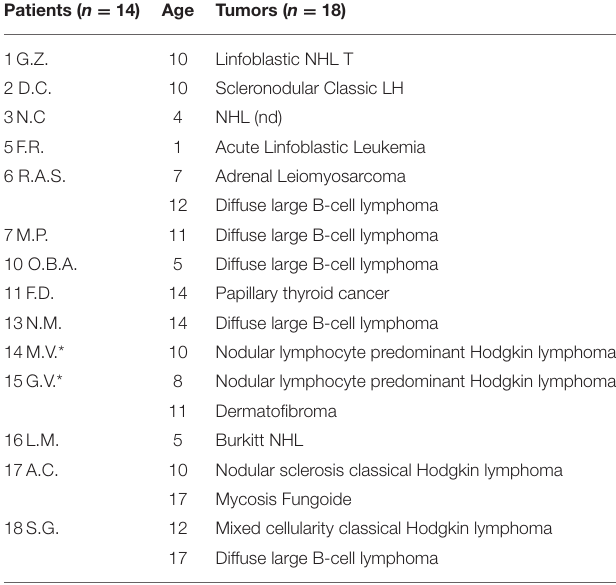
TABLE 1 | Tumors in pediatric age ( < 18 years).